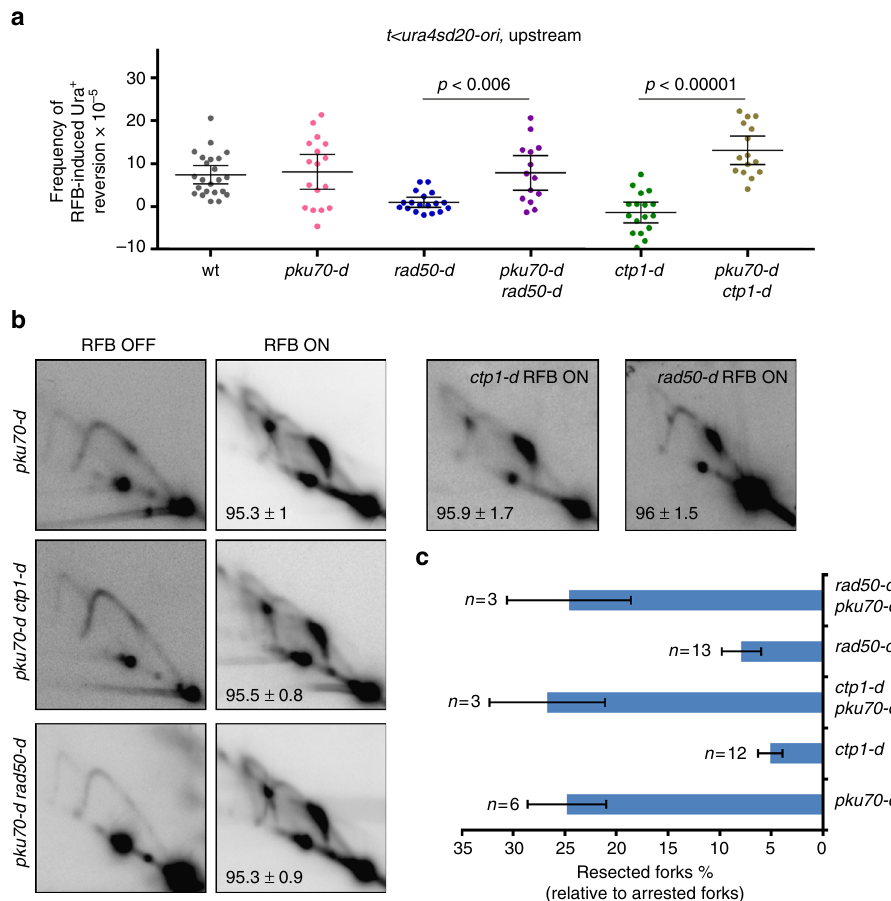
Fig. 3 The lack of Ku bypasses the initial resection of DSB-free arrested forks. a Frequency of upstream RFB-induced Ura + reversion, as described on Fig. 1c. b Representative RI analysis by 2DGE upon activation (RFB ON) or not (RFB OFF) of the RTS1 -RFB, as described on Fig. 1e. Numbers indicate the % of forks blocked at the RTS1 -RFB ± SD. c Quanti fi cation of forks undergoing resection ( “ tail signal ” ), relative to the intensity of terminally arrested forks, as described on Fig. 1f. Values are means of n samples from independent biological replicates ± 95%